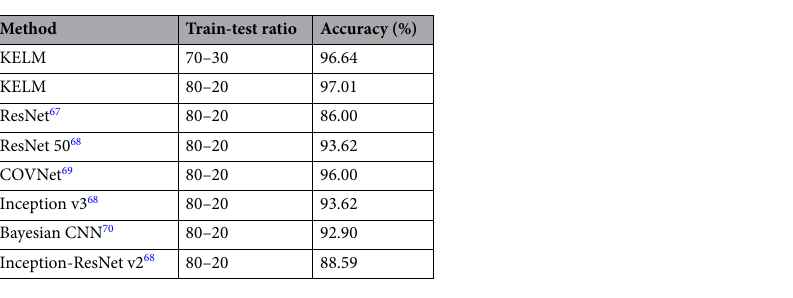
Table 7. Comparison of KELM with ResNet and other CNN based state-of-art approaches based on accuracy (%).